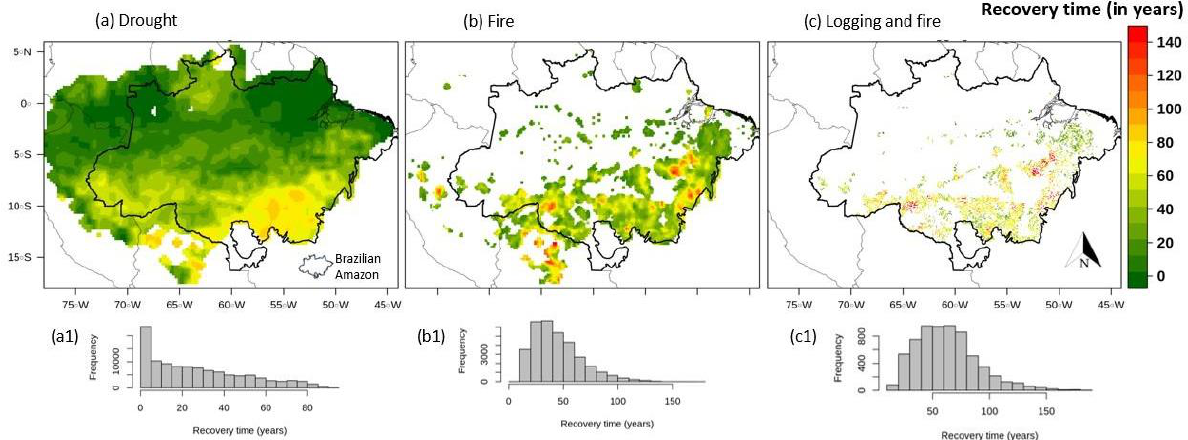
Figure 4. Aboveground recovery time (in years) for 2010 drought ( a ), fire areas that burned between 2003 and 2016 ( b ) and in areas that were both burned and logged ( c ). Histogram plots summarize AGB recovery pixels distributions (in years), for drought ( a1 ), fire ( b1 ) and logging + fire ( c1 ).